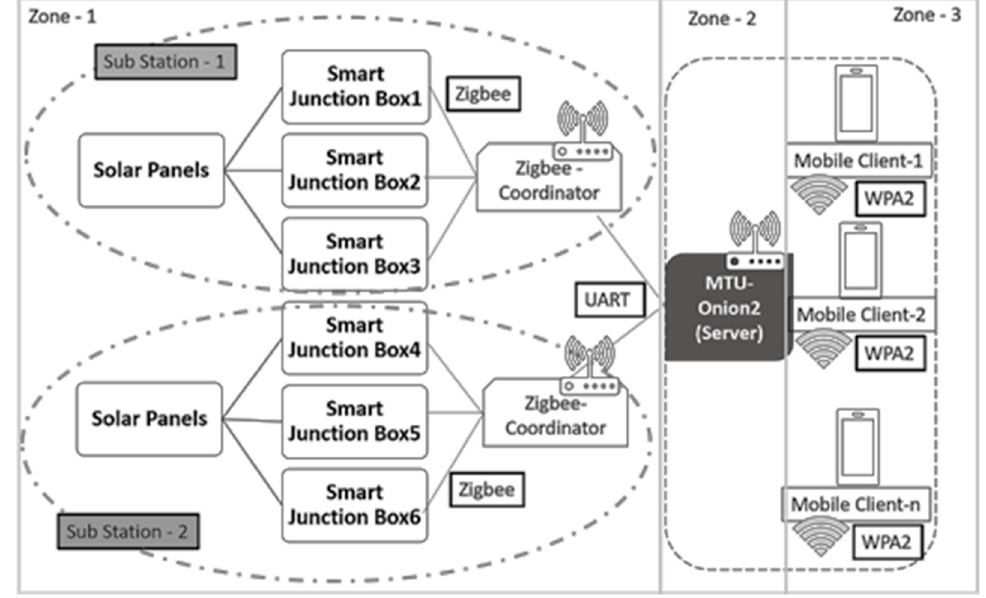
Figure 3. Block diagram of the Solar ‐ PV nano ‐ grid system.